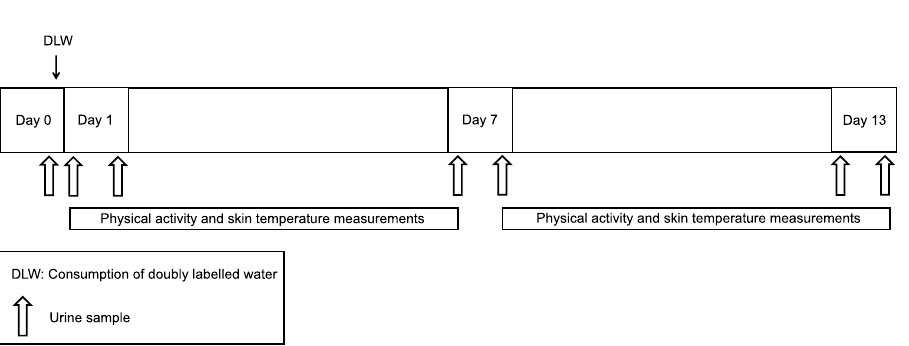
Figure 6. Protocol of the field work and measurements involved. DLW indicates consumption of the doubly labelled water. Urine sample collections are denoted by the larger arrows on Days 0, 1, 7, and